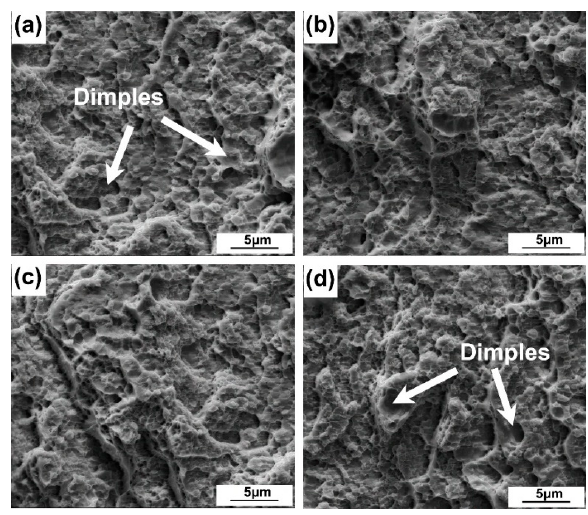
Figure 11. Tensile fractures of specimens cryorolled by ( a ) 50%, ( b ) 60%, ( c ) 70%, and ( d ) 80% and then annealed at 500 °C for 30 min.